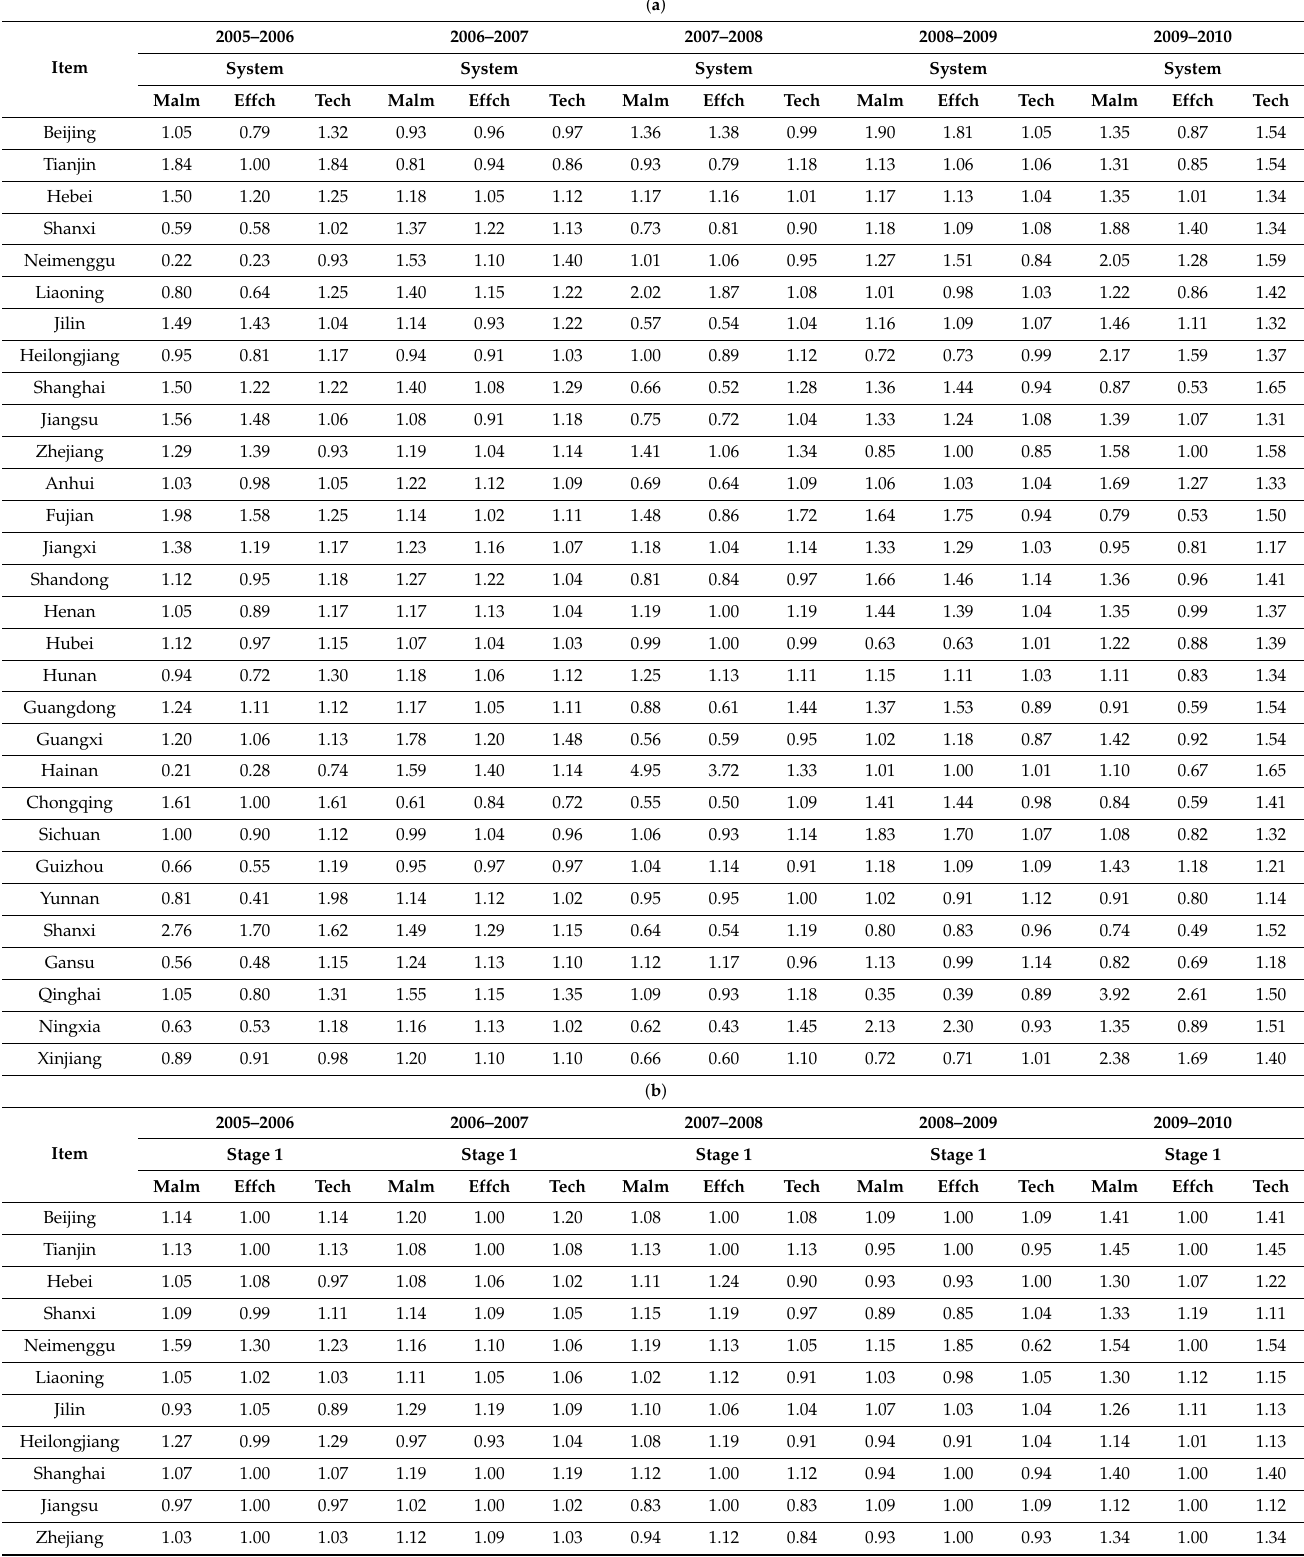
Table A3. ( a ) System Malmquist index value from 2005 to 2010; ( b ) Malmquist index value of production processes from 2005 to 2010; ( c ) Malmquist index value of treatment processes from 2005 to 2010. ( a